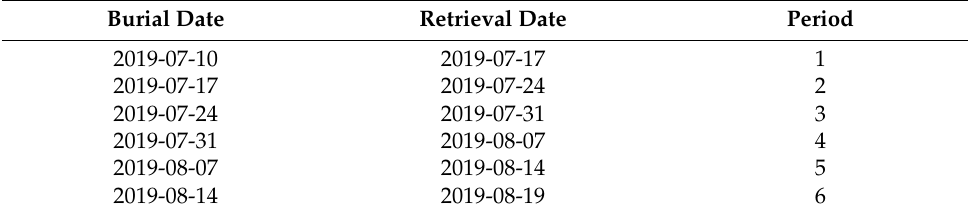
Figure 2. Experimental design with PRS ® probes installed in the root zone and in root exclusion cylinders. The probes are shown here before they were completely inserted into the soil. Table 2. Burial and retrieval dates for the PRS ® probes and related